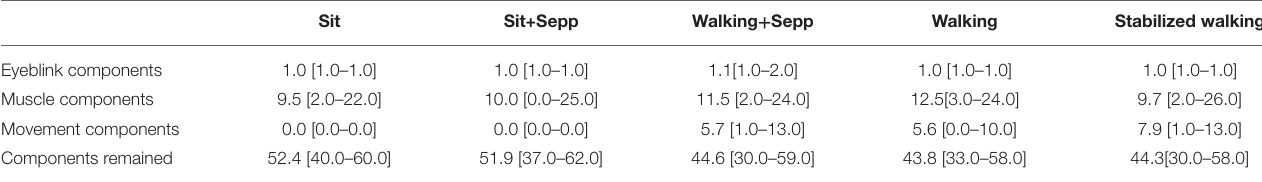
Values represent mean and